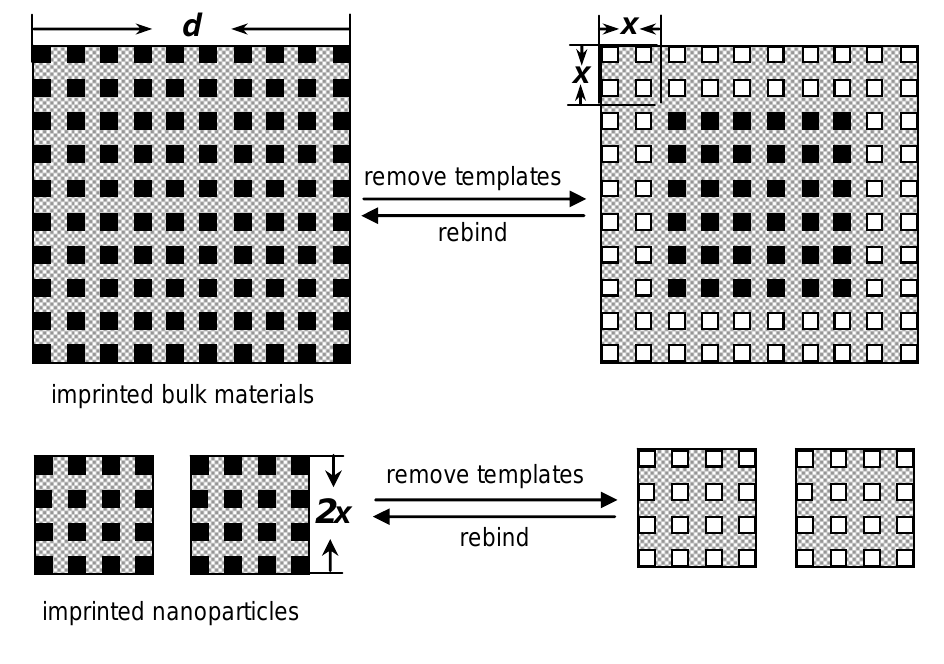
Figure 2. The schematic illustration of the distribution of effective binding sites in the imprinted bulky materials and the nanosized, imprinted particles after the removal of templates is done. Reprinted with permission from [16]. Copyright 2007 American Chemical